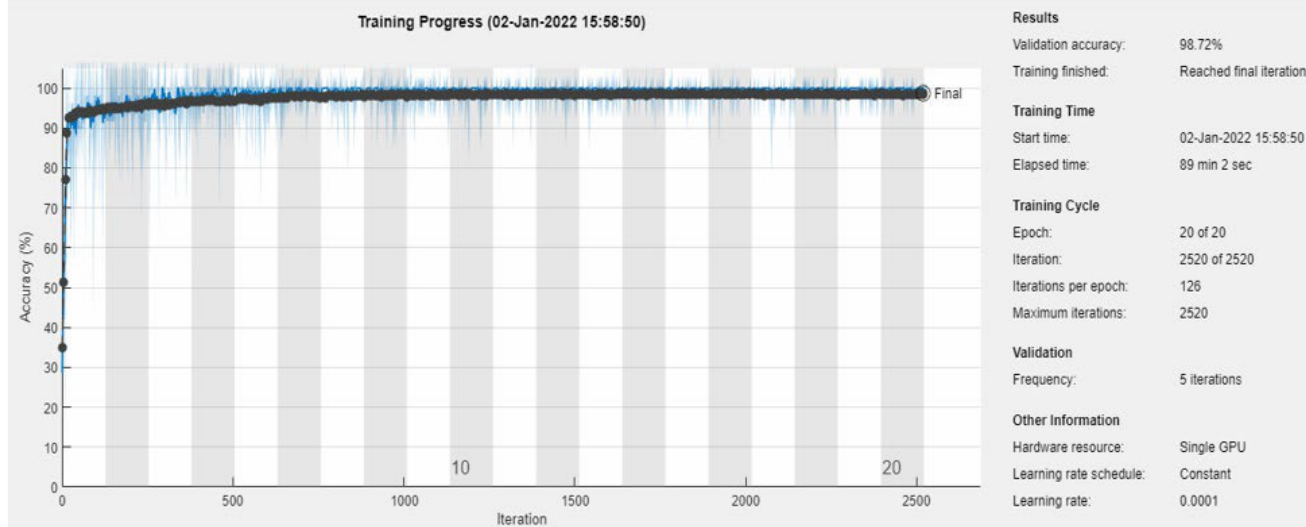
Appl. Sci. 2023 , 13 , x FOR PEER REVIEW Figure 11 . Accuracy of Messidor and ODIR dataset. Figure 11. Accuracy of Messidor and ODIR dataset.